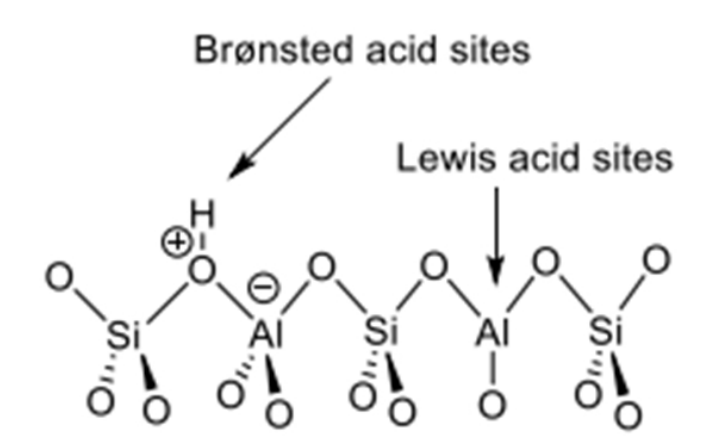
Figure 1. Brønsted and Lewis acid sites in zeolites